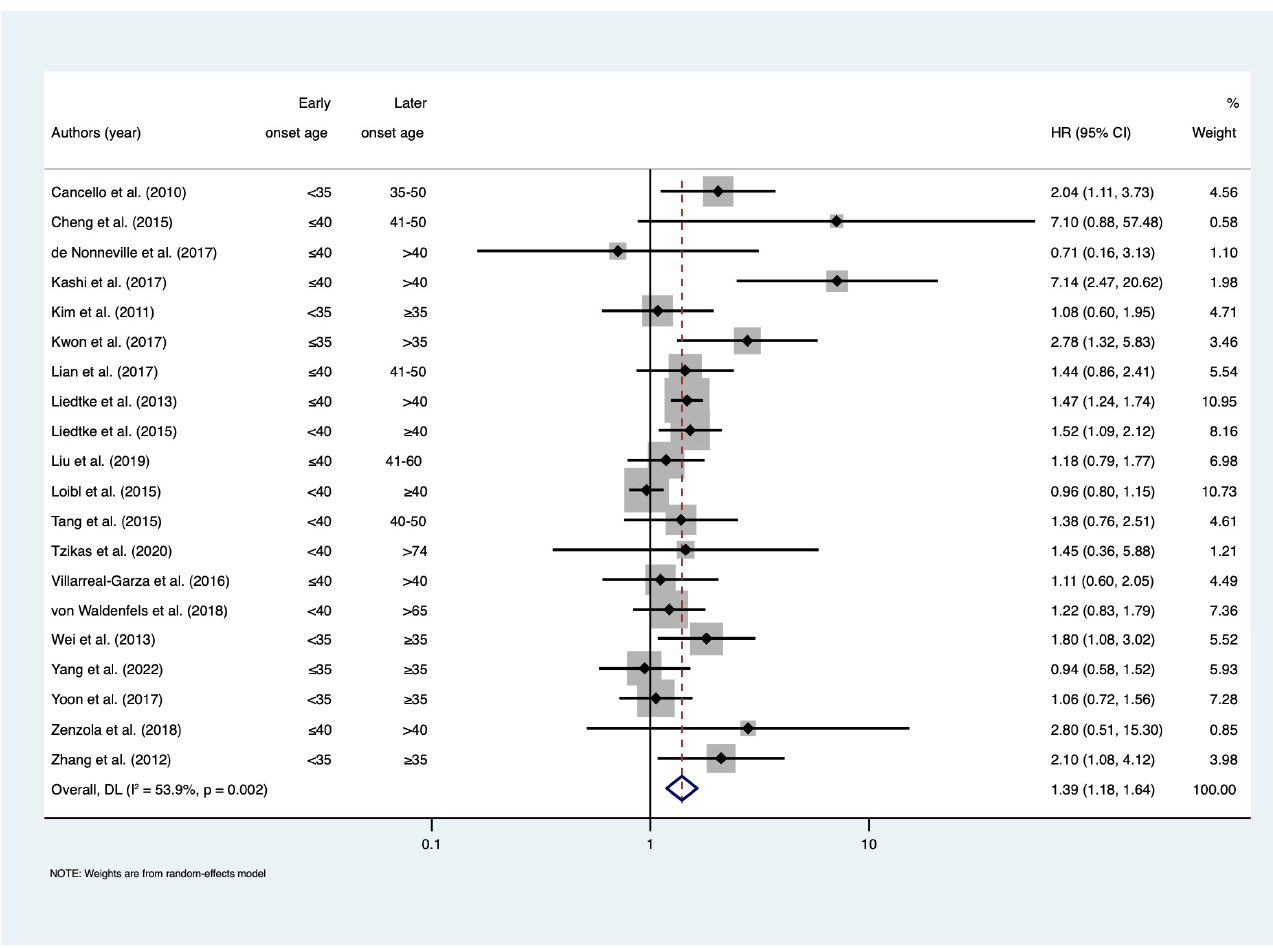
Figure 2. Forest plot for meta-analysis of disease-free survival. Hazard ratios less than 1 show favourable outcomes in early-onset age group; hazard ratios greater than 1 show poorer outcomes in early-onset age group. References [20,21,23,28,29,31,33–37,41,42,44–47,49,51,52]. Abbreviations: CI = confidence interval; HR = hazard ratio.